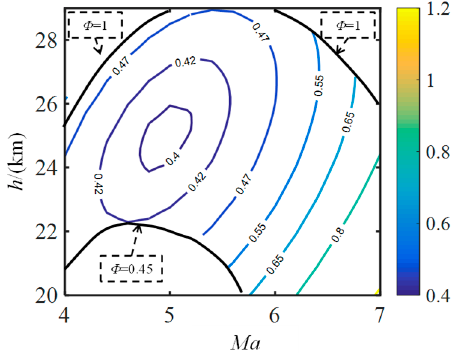
Figure 4. Contour of fuel consumption averaged by range.